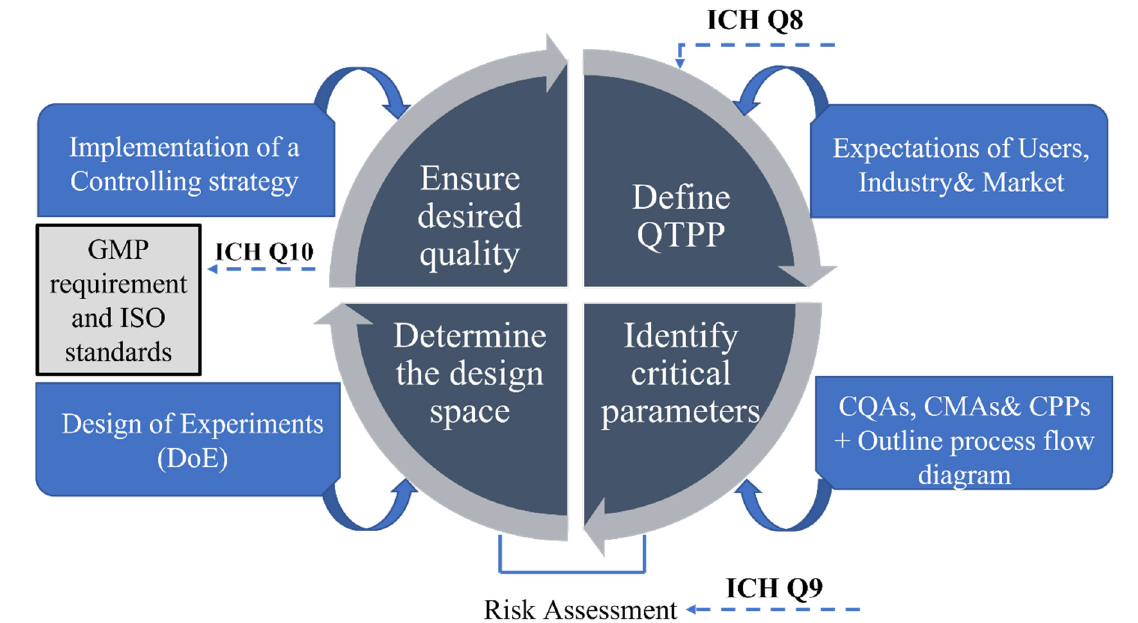
Figure 2. QbD quality management tool showing the principal steps. Abbreviations: ICH: International Council for Harmonization, QTPP: Quality target product profile, CQAs: Critical quality attributes, Critical materials attributes, Critical process parameters, GMP: Good manufacturing pro- cess.